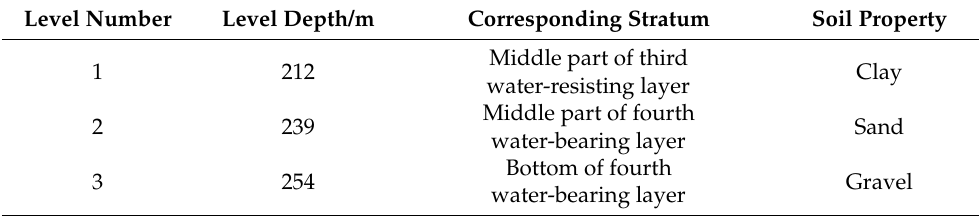
Table 2. Locations of monitoring level